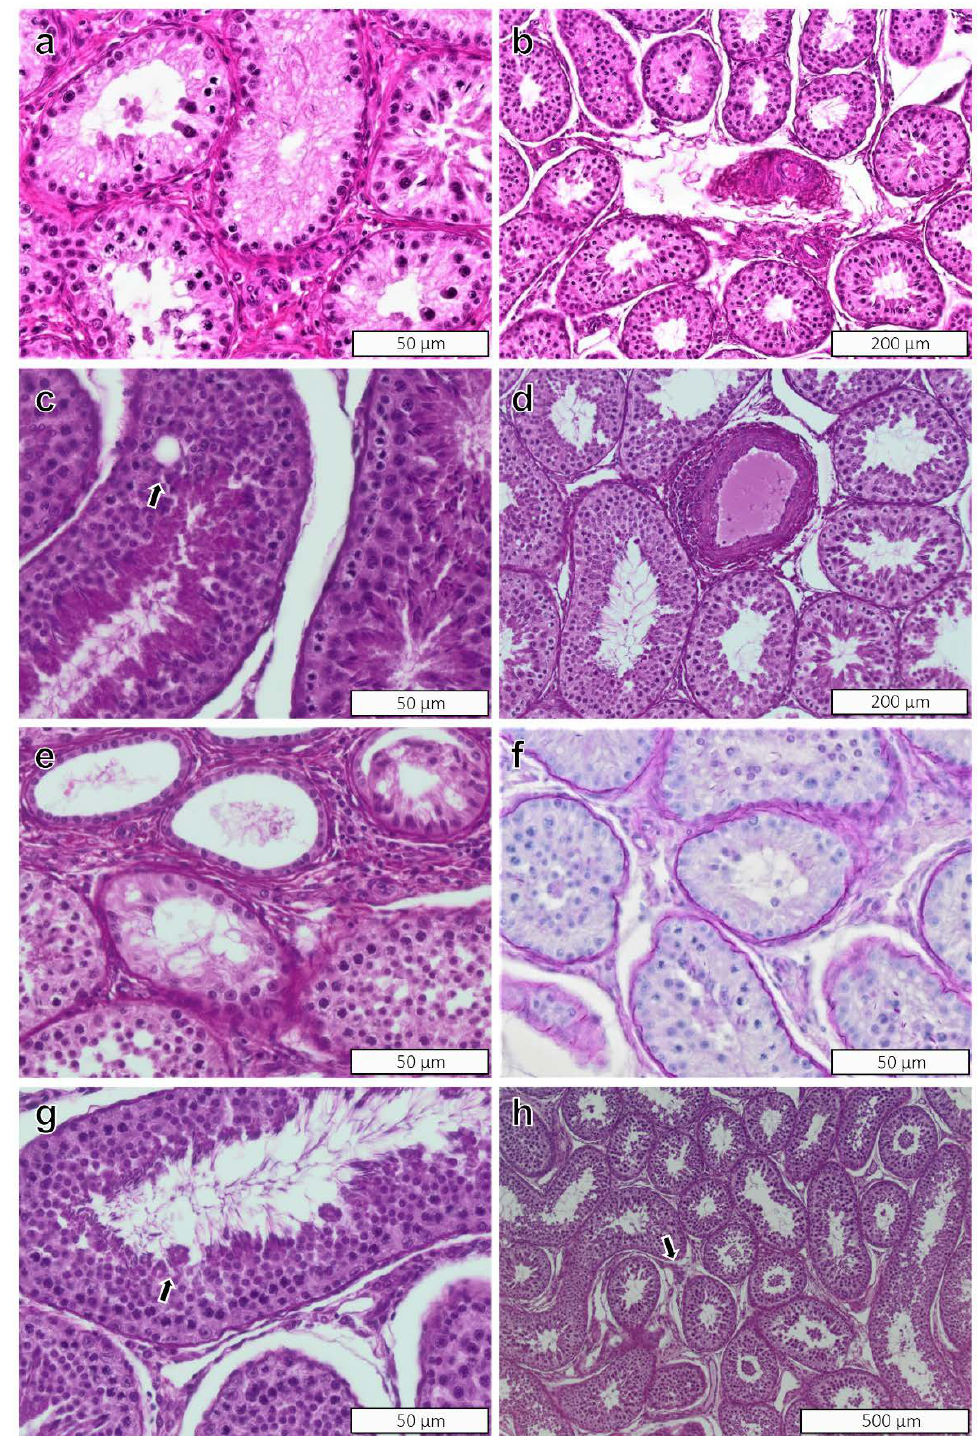
Figure 2. Testes of rams. Spontaneous changes in testis parenchyma and interstitial tissue of rams regardless of treatment group. ( a ) Testis from ram no. 2 with immature testis; ( b ) testis from ram no. 1 with partially mature testis; ( c ) vacuolation of Sertoli-only cell; ( d ) periarteritis; ( e ) hypoplastic tubules near rete testis; ( f ) Sertoli-only tubule; ( g ) multinucleated cells; ( h ) infiltrates of mononuclear cells. H&E stain, with exception of Figure 1f which is stained with PAS-H. Magnification in figures: ( a , c , e , f , g ) = ×40; ( b , d ) = ×20; ( h ) = ×10.